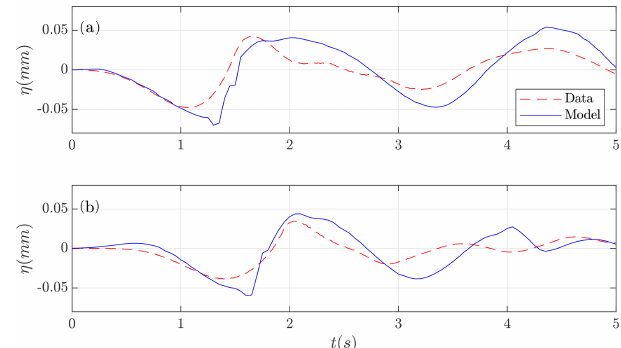
Figure 13. Subaerial test case. Lab-measured run-up (red) and nu- merical time series (blue) at run-up gauges (a) RG2 and (b) RG3.